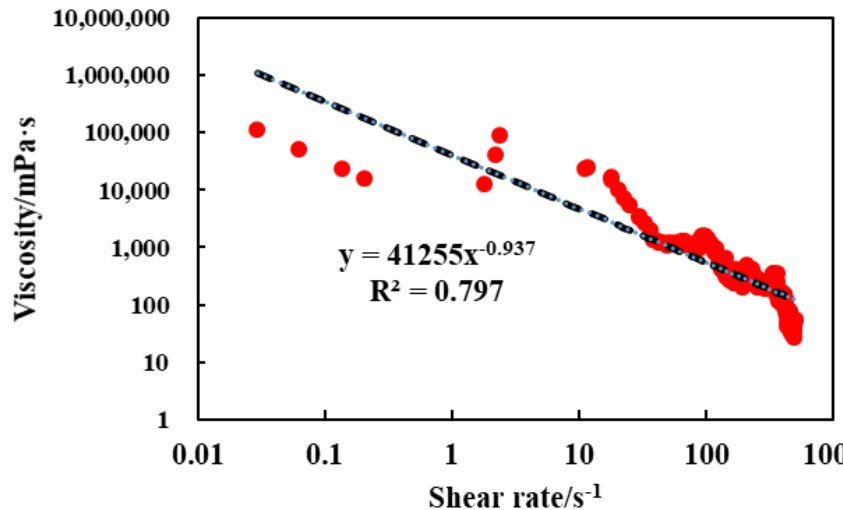
Figure 6. Relationship between viscosity of cross-linked acid and shear